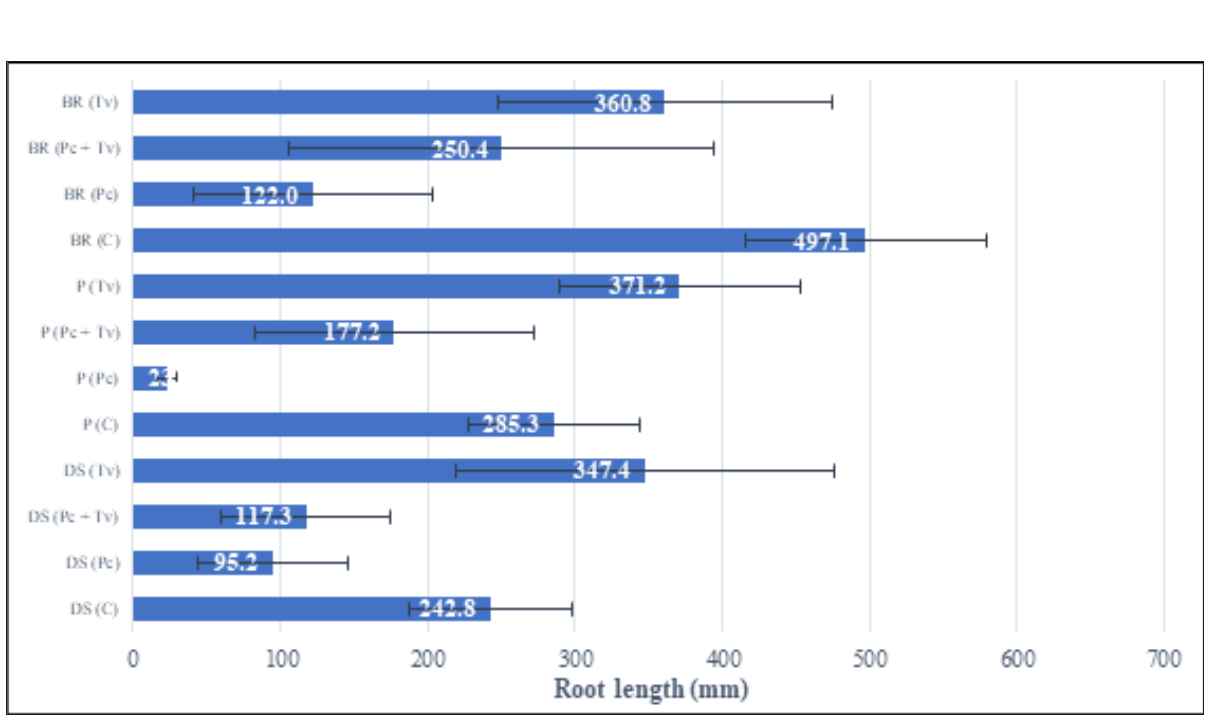
Figure 1: Root length (mm), according to control treatments of P. capsici on T. viride under three sowing methods ( α =